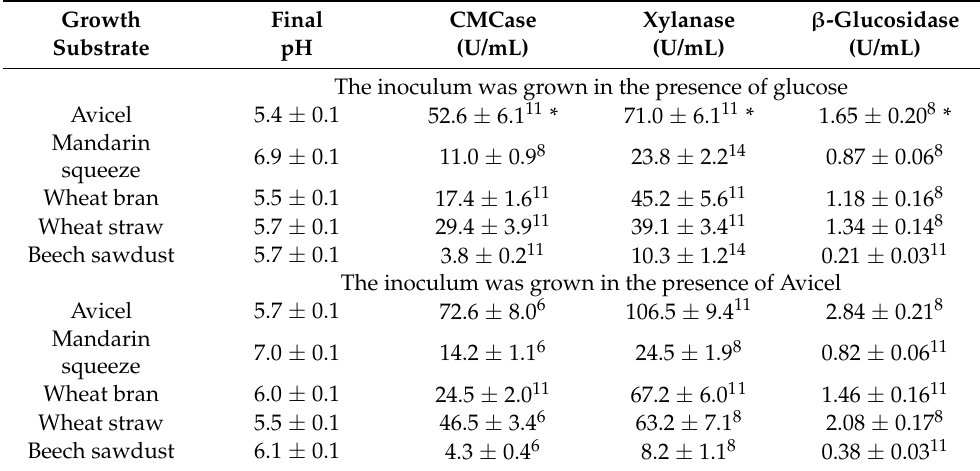
Table 2. Effect of the carbon source in the inoculum medium on the enzyme activity of I. lacteus .